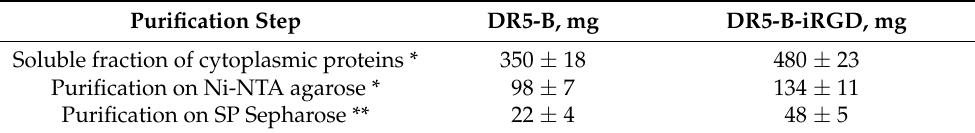
Table 1. Yields of DR5-B and DR5-B-iRGD proteins from 200 mL liter of cell culture during purification.